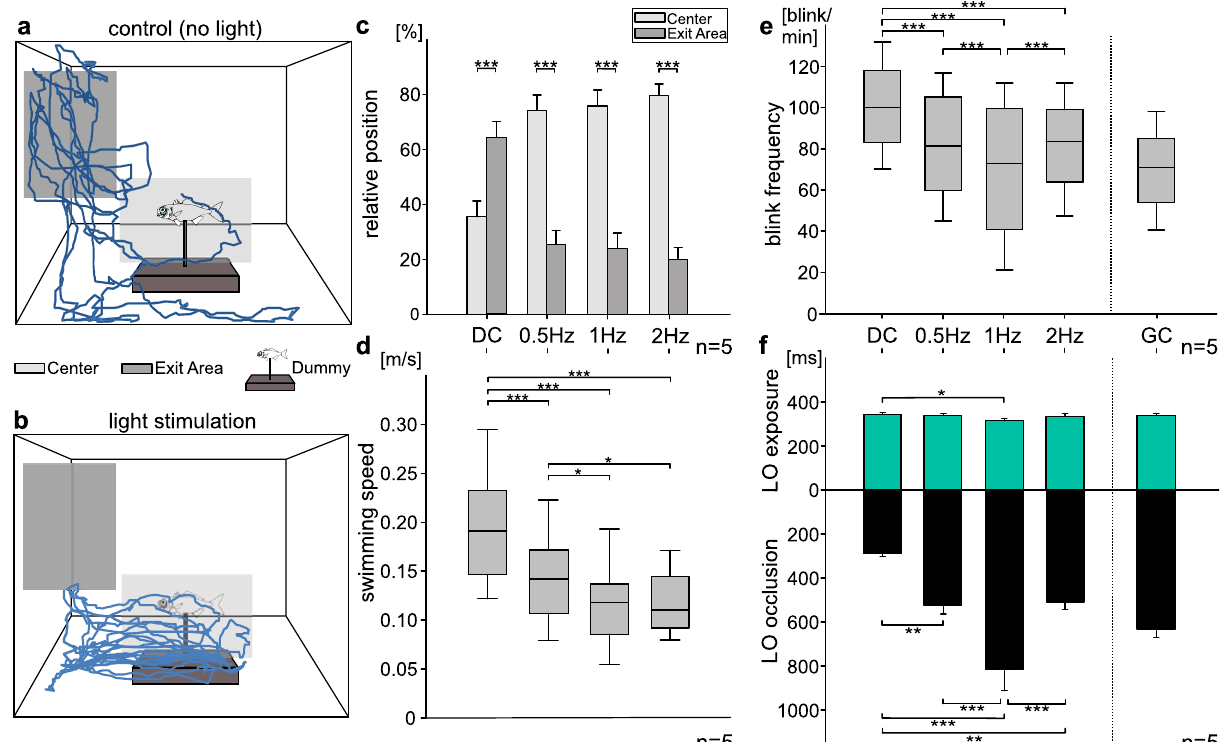
Figure 1. Frequency-dependent light stimuli transmitted by artificial light organs mediate changes in positioning, swimming speed, blink frequency and light organ occlusion of A. katoptron . ( a , b ) Example trajectories of A. katoptron (60 s) without ( a ) and with ( b ) a 1 Hz light stimulation of the fish dummy. ( c ) Relative positioning in exit or center area of isolated A. katoptron during different light stimuli (DC; 0.5, 1, 2 Hz) (n = 5). ( d ) Swimming speed of isolated A. katoptron during different light stimuli (DC; 0.5, 1, 2 Hz) (n = 5). ( e ) Blink frequencies of isolated A. katoptron induced by different light stimuli (DC; 0.5, 1, 2 Hz) (left) in comparision to blink frequencies detected in a small group of five individuals in the reef tank (GC) (right) (n = 5). ( f ) Mean light organ exposure and occlusion times during different light stimuli (DC, 0.5, 1, 2 Hz) (left) in comparision to exposure and occlusion times measured in a small group of five individuals in the reef tank (GC) (right) (n = 5). Figures were created with SigmaPlot 12.0 (www. sigma plot. co. uk) and processed with CorelDraw Graphics Suite 2017 (www. corel draw. com). DC, dark control; GC, group control. Significance values are reported as * p < 0.05, ** p < 0.01, *** p < 0.001. Error bars indicate ±